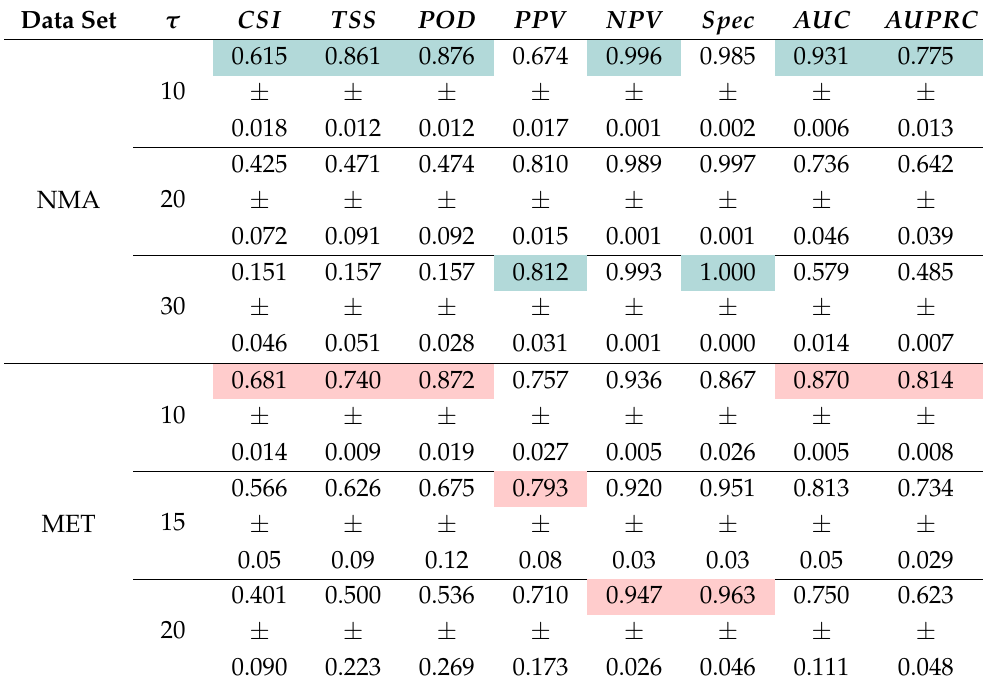
Table 2. Experimental results, using 95%